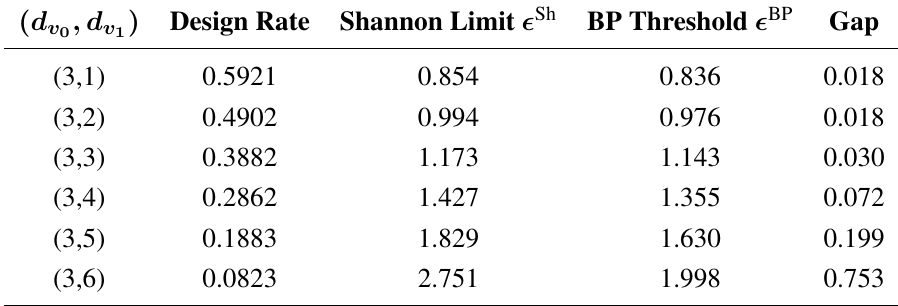
over binary-input (BI)-AWGN channels. { 0 , 1 }